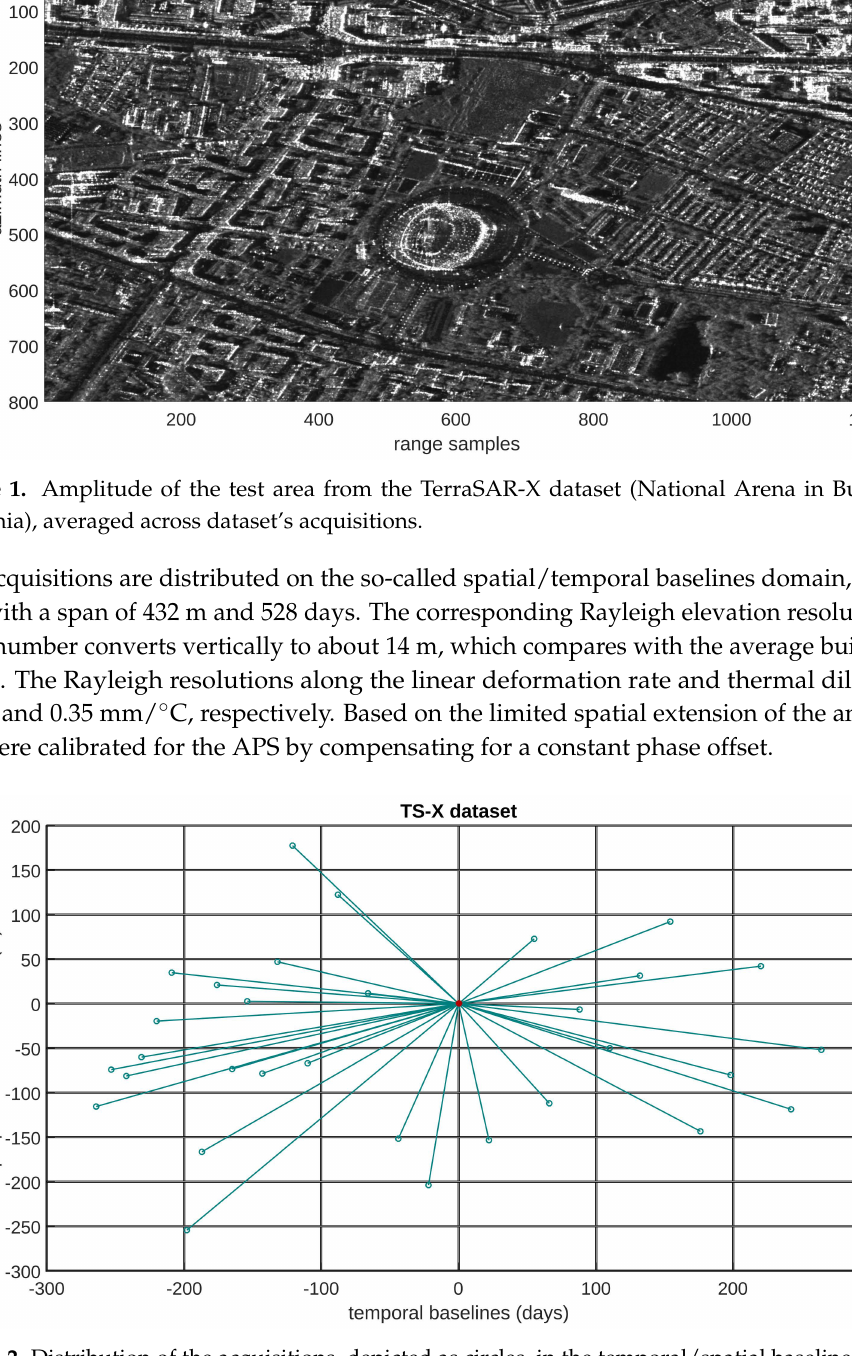
Figure 2. Distribution of the acquisitions, depicted as circles, in the temporal/spatial baseline domain. Red circle corresponds to the master